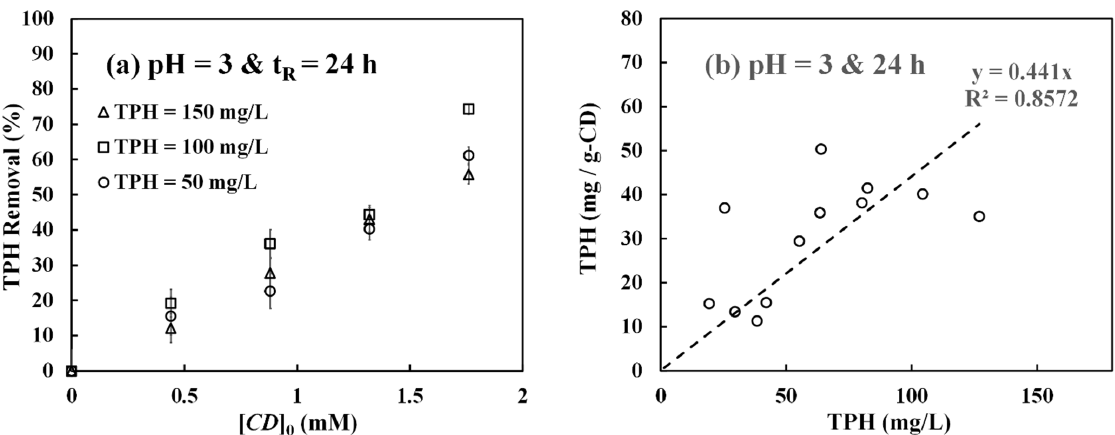
Figure 9. TPH removal by pure β -CD solution: ( a ) TPH removal efficiency as a function of β -CD concentration ([ CD ] 0 ) at three different initial TPH concentrations (150, 100, and 50 mg/L); ( b ) Mass of TPH partitioning on β -CD (mg/g-CD) as a function of equilibrium TPH concentration (mg/L).